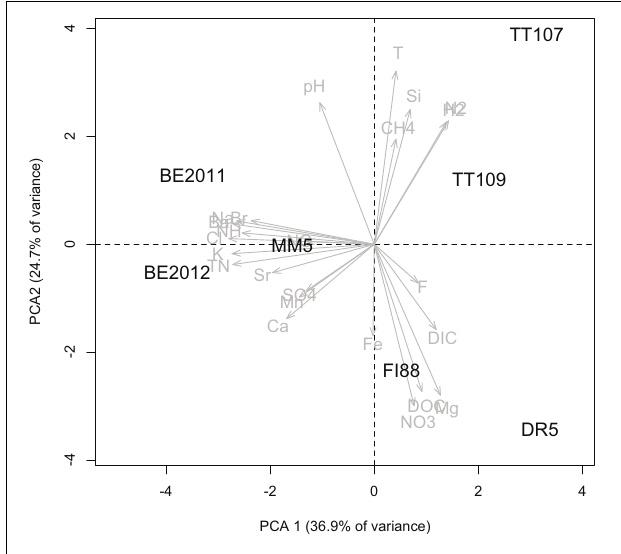
FIGURE 1 | Principle component analysis of physical and chemical characteristics of the fracture water